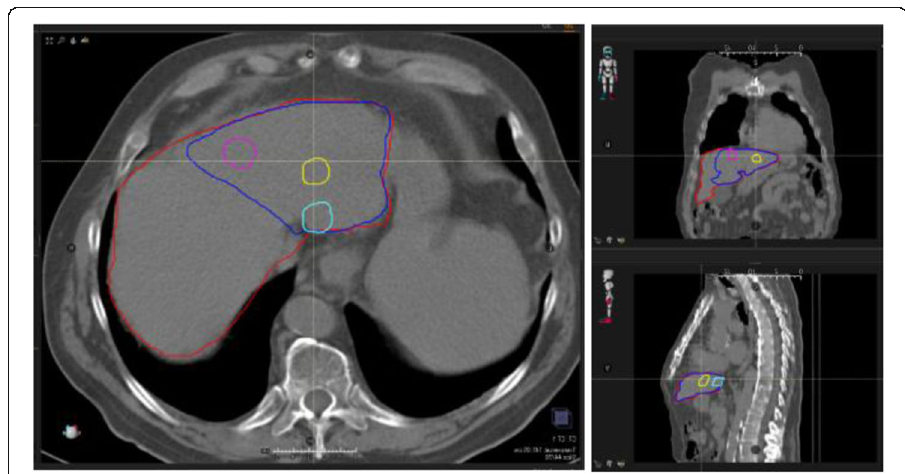
Fig. 1 Volumes of interest contoured on the 99m Tc-MAA SPECT-CT images used for the pre-therapy dosimetry assessment corresponding to patient 12: whole liver volume delimited by red line, target volume delimited by blue line and individual tumors delimited by pink, yellow, and light blue lines